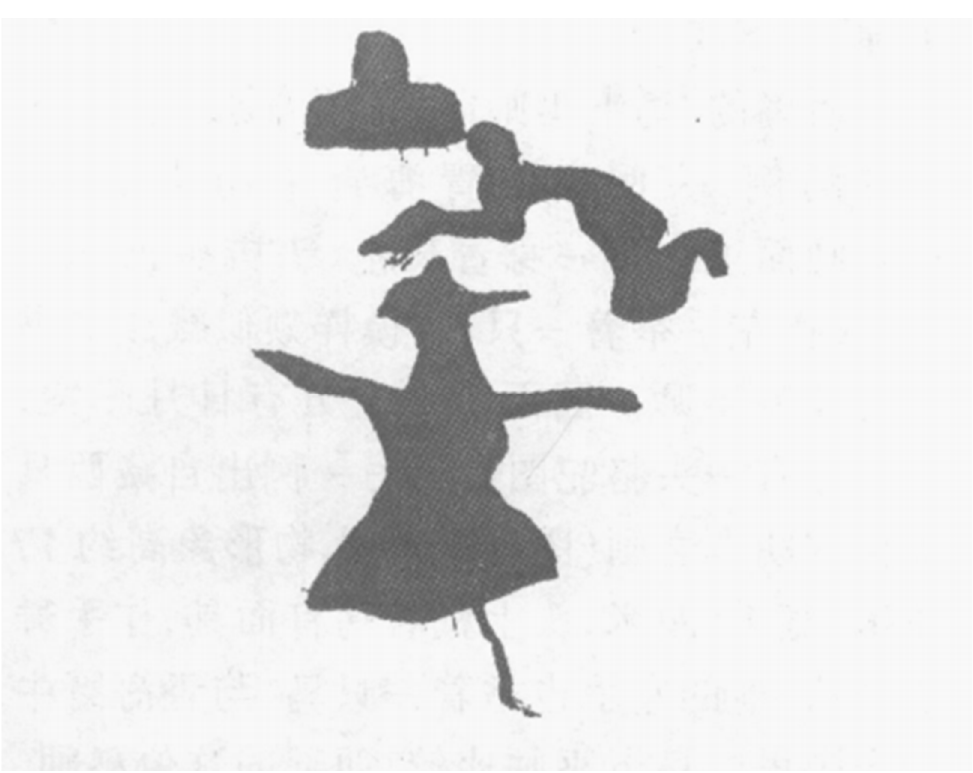
Figure 2. Bird shaman holding a bird in the left hand and dancing with hands (rock painting of Rurirangka, Ritu 日土鲁日朗卡 , Tibet) (Zhang 2006, p. 56). 3.2. Mural Bird Totems in Dunhuang Cave: The Divine and Demonic Energy of Music The variation of the Sutra of the Visualization of Amit ā yus S ū tra ( Fo shuo guan wuliang- shou fo jing 佛说观无量寿經 or Guan jing 觀經 ) from Cave 25 of the Yulin 榆林 Cave in the Mogao Caves at Dunhuang is shown in Figure 3. Three human-faced birds are posed in different positions, with lutes in their arms and drums around their waists. A person plays